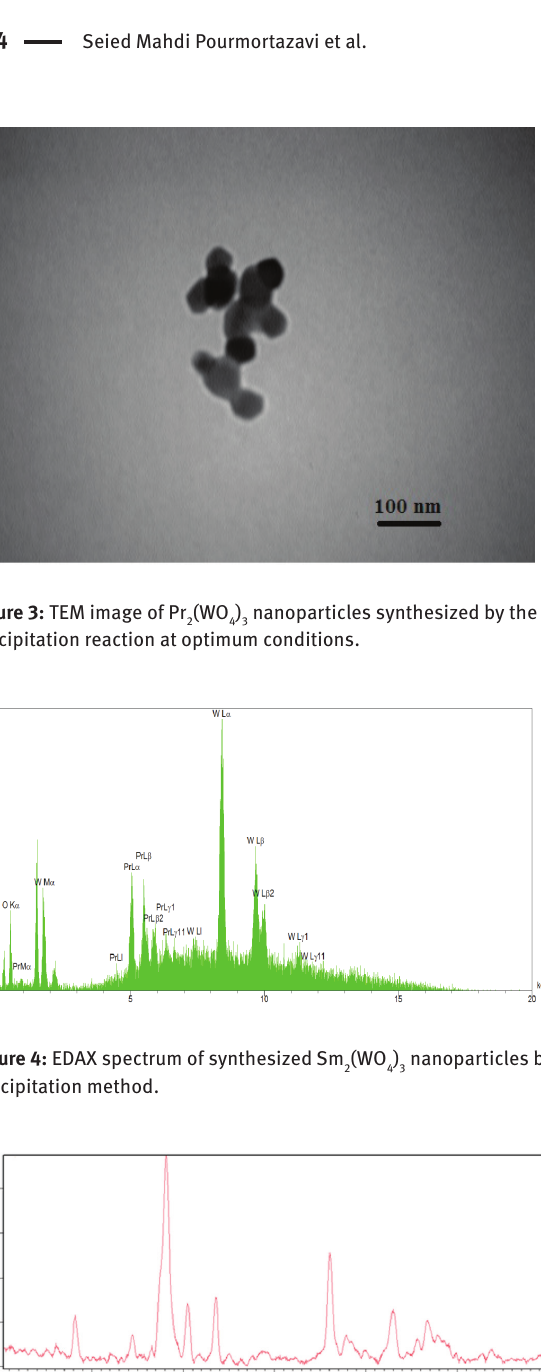
Figure 5: XRD pattern for synthesized Pr precipitation reaction at optimum conditions.